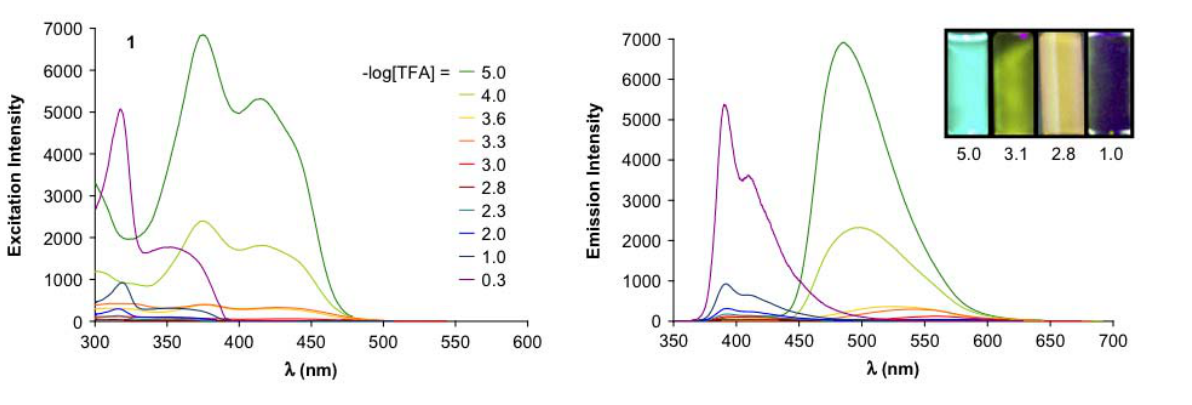
Figure 23. Excitation (left) and emission (right) spectra of TFA titration of 57i in CH (ca. 20 mM). Inset: photographs of vials of analyte solutions at indicated -log[TFA] under illumination by high-intensity 365 nm lamp. Reprinted from reference [190] Tetrahedron , 64 , Spitler, E. L.; Haley, M. M., Dynamic proton-induced two-stage emission switching in donor-functionalized bis(dehydrobenzo[n]annuleno)benzenes and 1,2,4,5-tetrakis- (phenylethynyl)benzene., 11469-11474, (Copyright 2008, reprinted with permission from